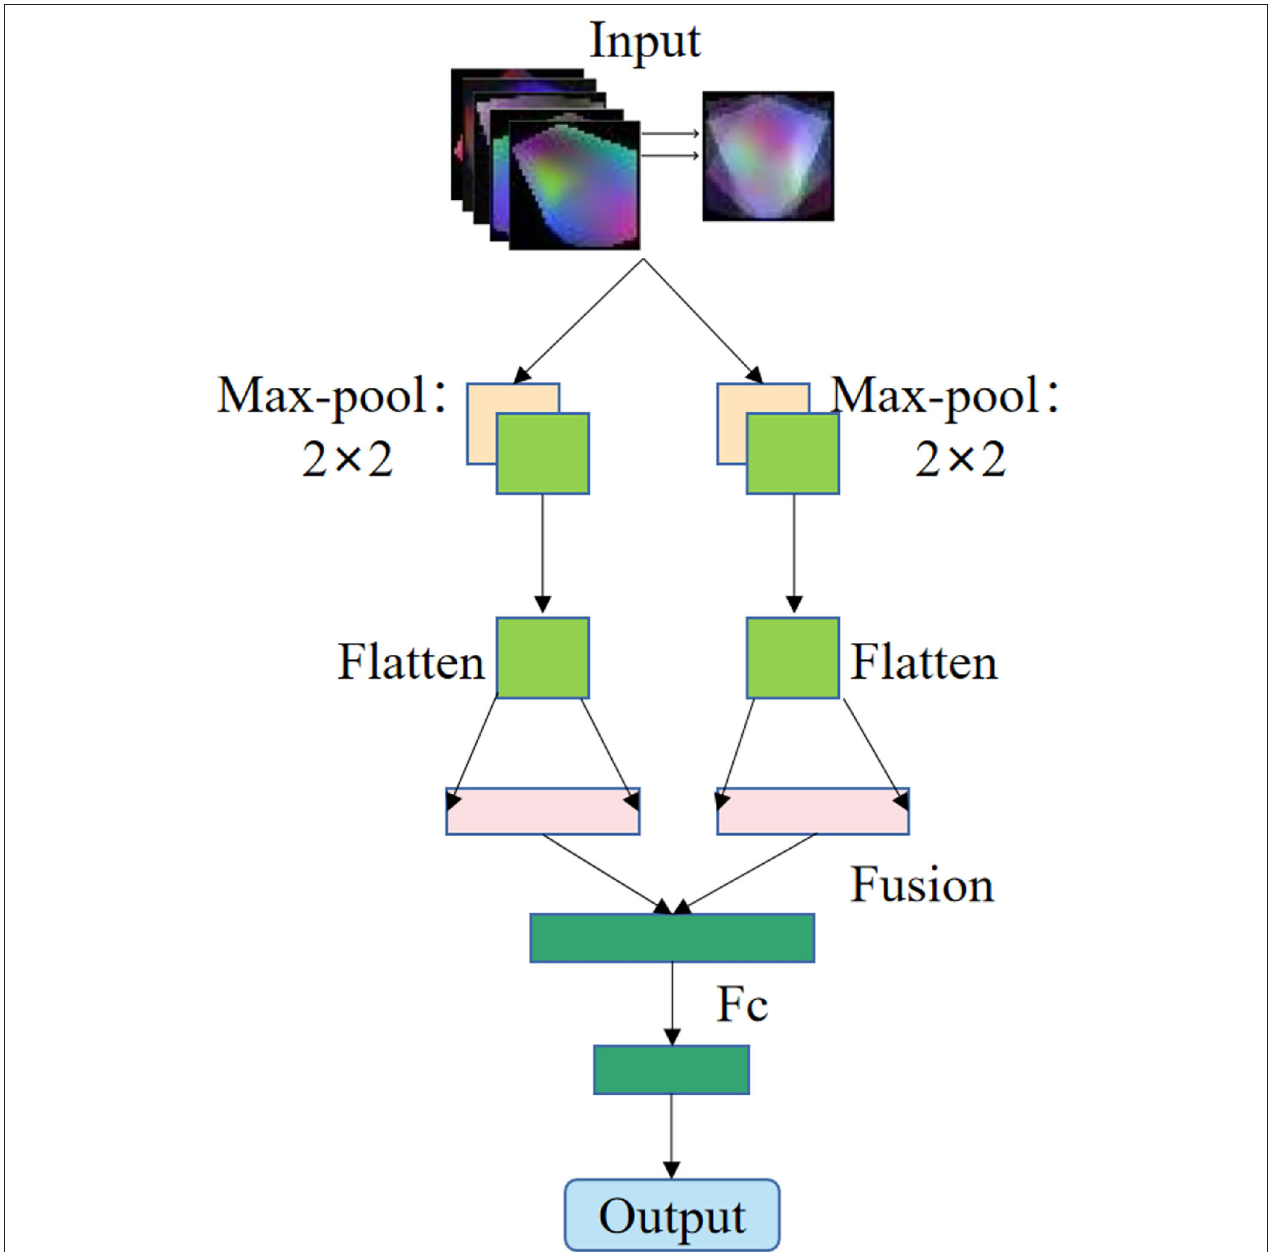
FIGURE 2 | Schematic diagram of multispectral image fusion in multiple brain